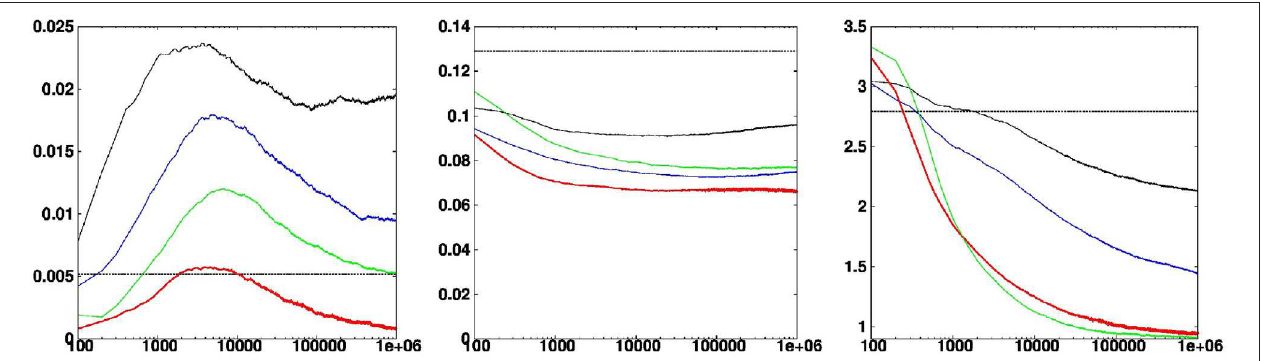
FIGURE 9 | Reliability (Left) , resolution (Middle) and optimality (Right) scores as a function of the number of accepted iterations. The scores are shown for the solutions obtained without localization (black curve), with optimal localization ( l 1 localization ( l 1 64, green curve). They can be compared to the score of the prior ensemble (thick dashed horizontal =